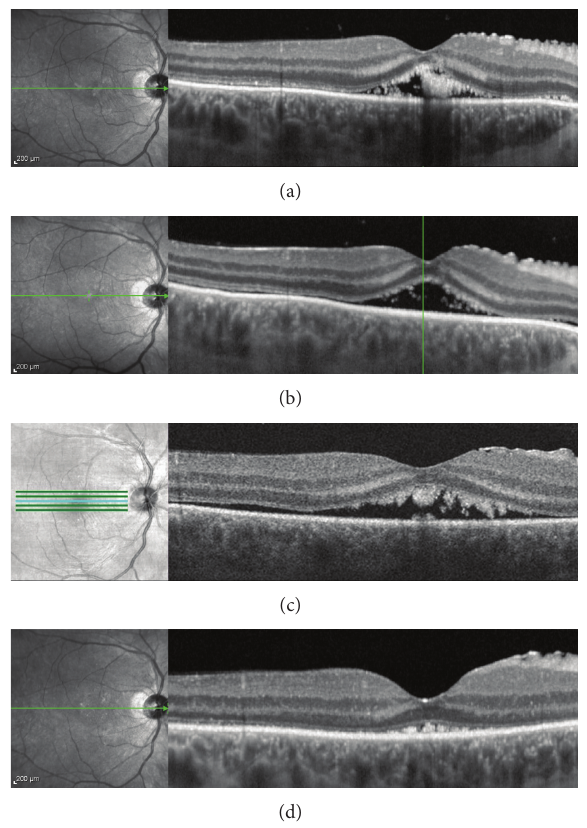
Figure 2: Optical coherence tomography scans of the fovea before (a) and one week after treatment showing reduced volume of shaggy photoreceptors (b). At six weeks, there is recurrent subretinal fluid with presence of shaggy photoreceptors (c) which again resolved four months later